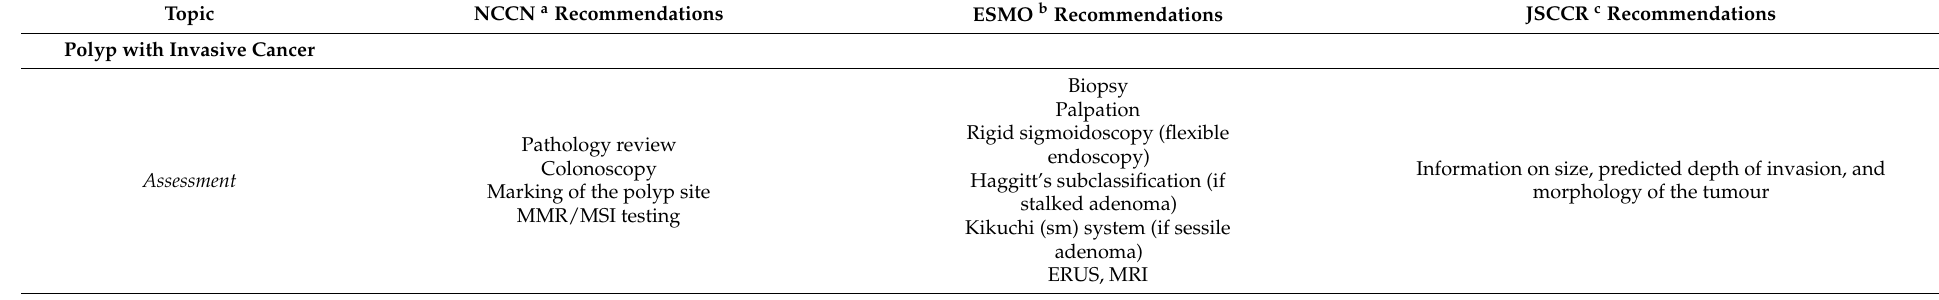
Table 2. Rectal cancer: Precancerous lesions and invasive cancer: assessment and